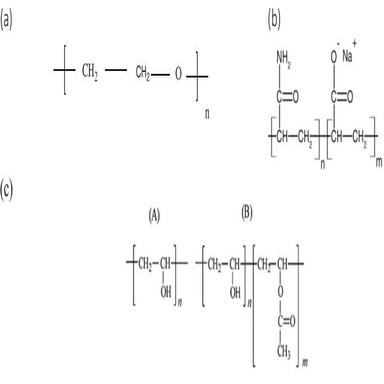
Structure of repetitive unit of (a) PEO (b) anionic PAM and (c) PVA. Reproduced respectively from and with permission.